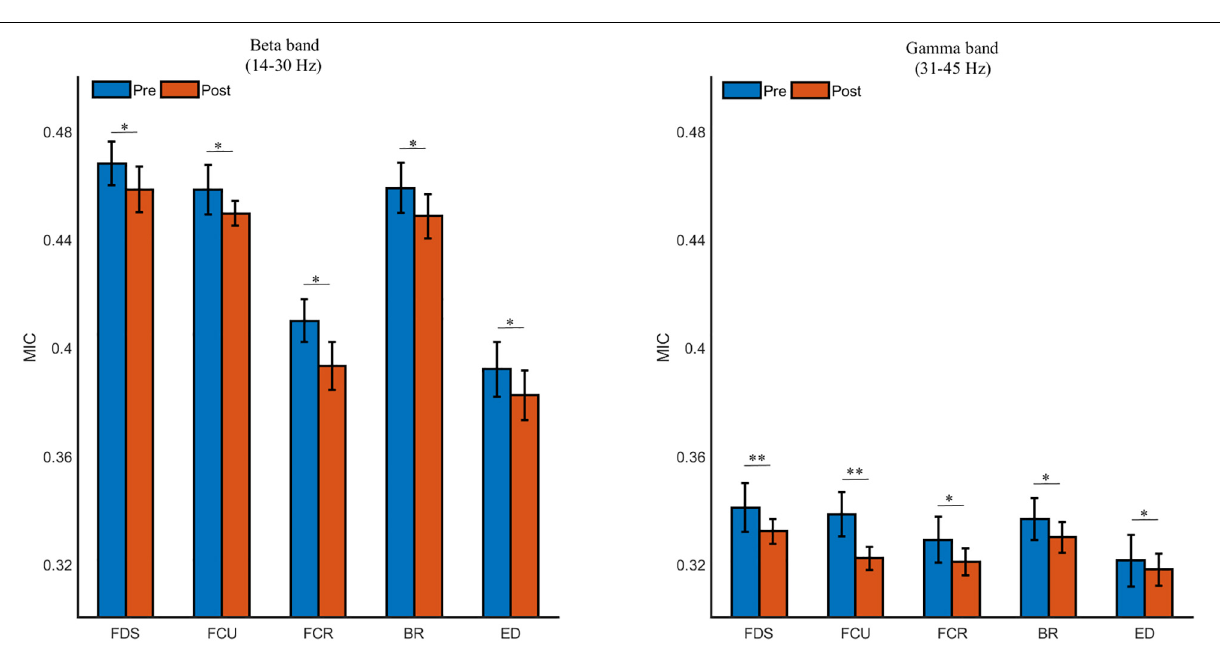
FIGURE 8 | The grand averages of the beta- and gamma-band cortico-muscular connectivity during the pre- and post-fatigue tasks for FDS, FCU, FCR, BR, and ED. ∗ p < 0.05, ∗∗ p <